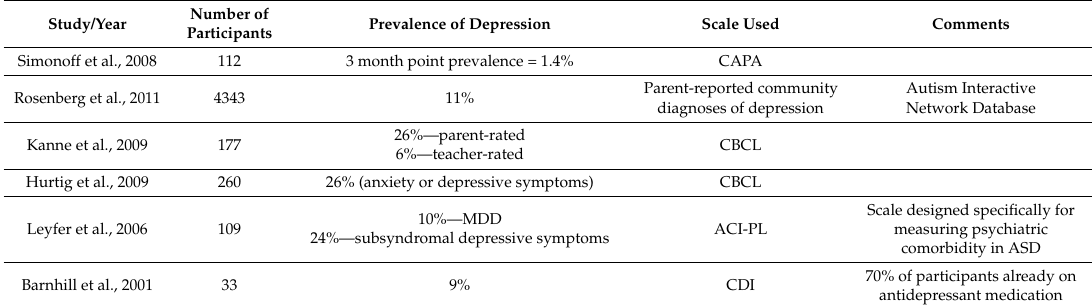
Table 1. Prevalence Studies of Depression in Youth with autism spectrum disorder